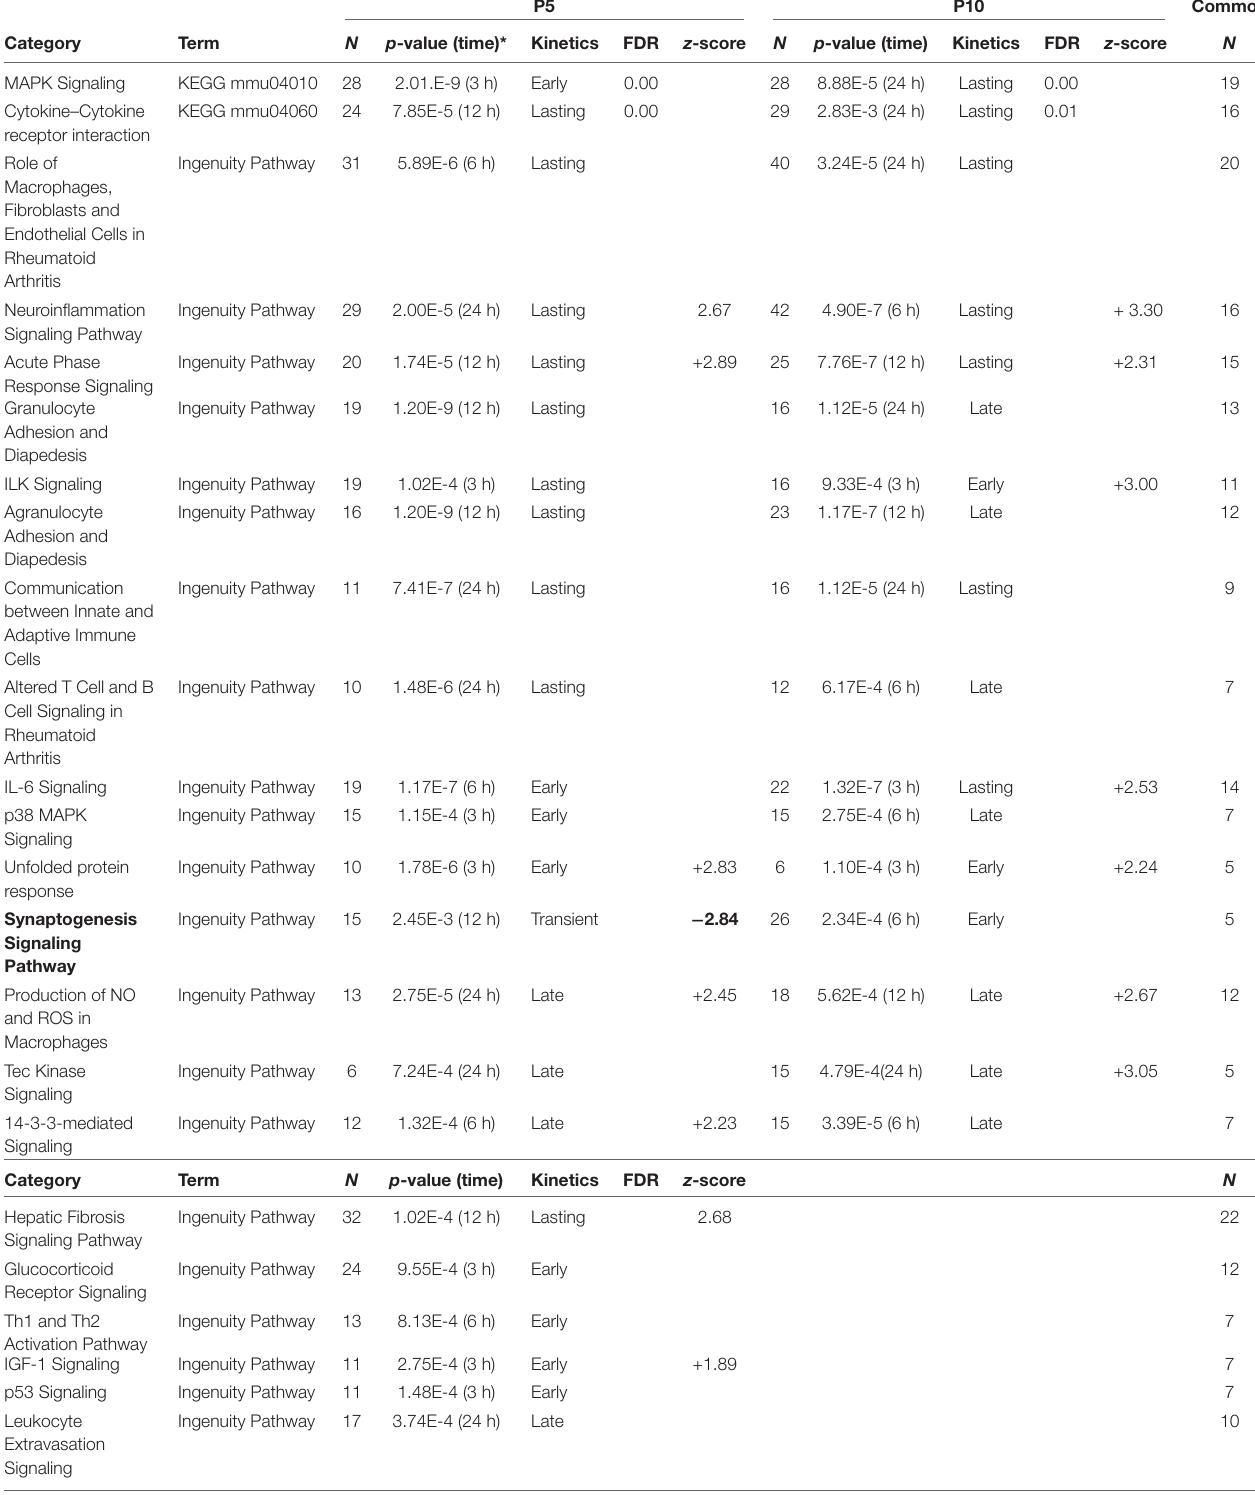
TABLE 1 | Pathways extracted from the series of genes affected after HI (inductions and repression) at P5 or P10. P5 P10